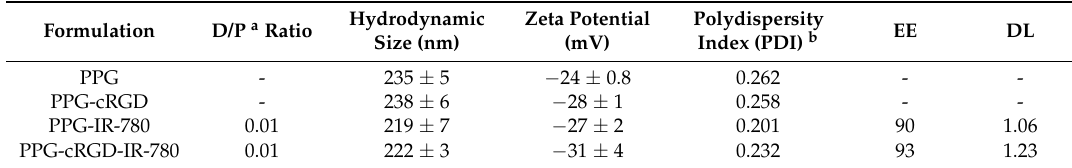
Table 1. Physicochemical characteristics of